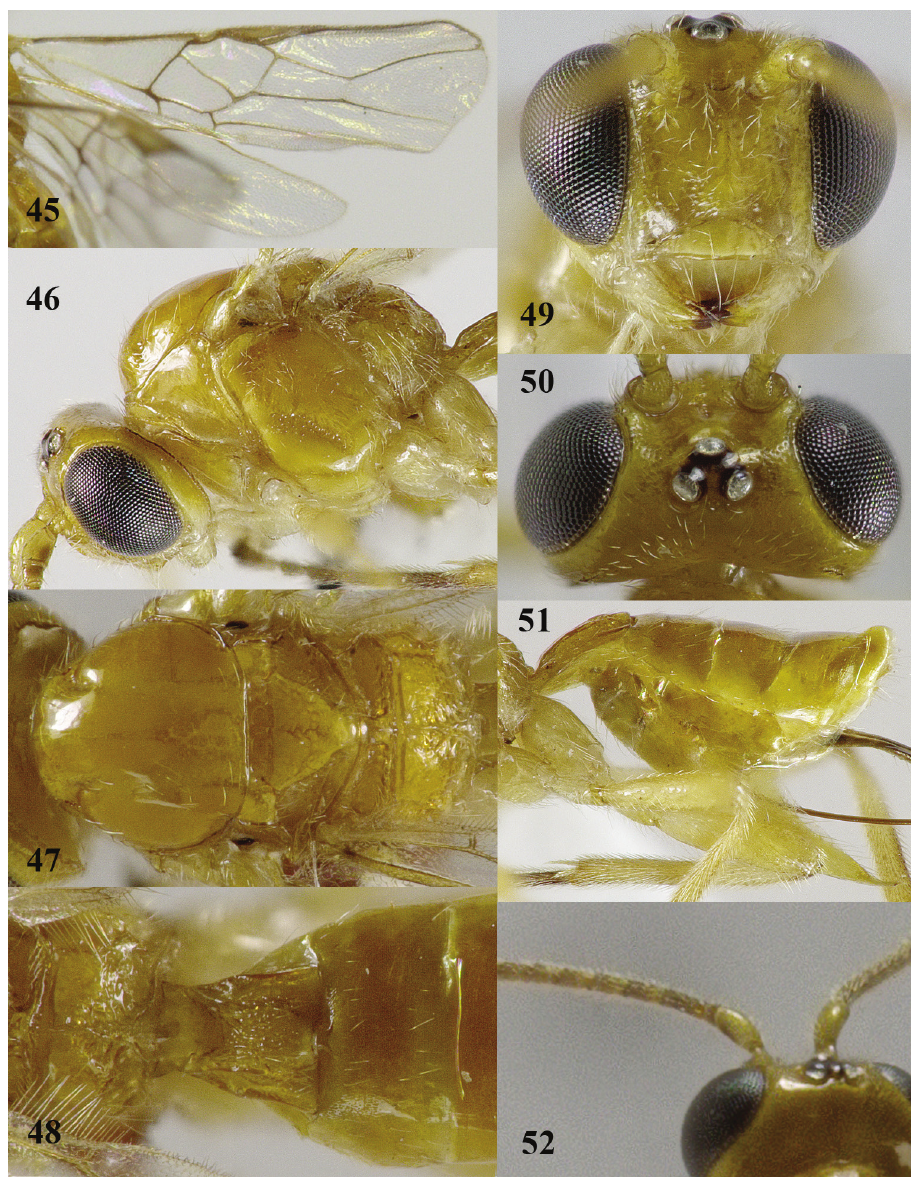
Figures 45–52. Psyttalia majocellata sp. n., ♀ , holotype. 45 wings 46 head and mesosoma lateral 47 mesosoma dorsal 48 propodeum and first–third metasomal tergites dorsal 49 head anterior 50 head dorsal 51 hind femur and hypopygium lateral 52 base of antenna. setose and punctate (Fig. 50); labrum nearly flat; clypeus transverse, convex, punctate and its ventral margin truncate and thin (Fig. 49); width of clypeus 2.7 times its maximum height and 0.7 times width of face; hypoclypeal depression wide and